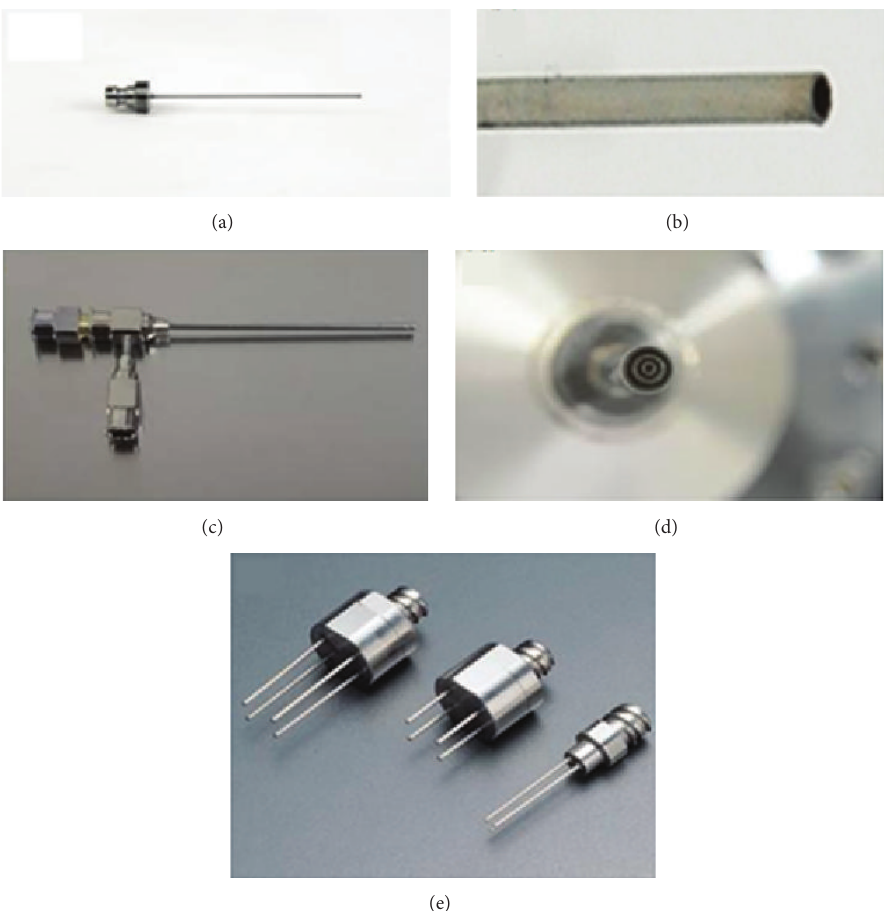
Figure 4: Various needles used in electrospinning: (a) standard needle; (b) inlet of standard needle; (c) core-sheath needle; (d) inlet of core- sheath needle; (e) coaxial needle with double or multiple capillary